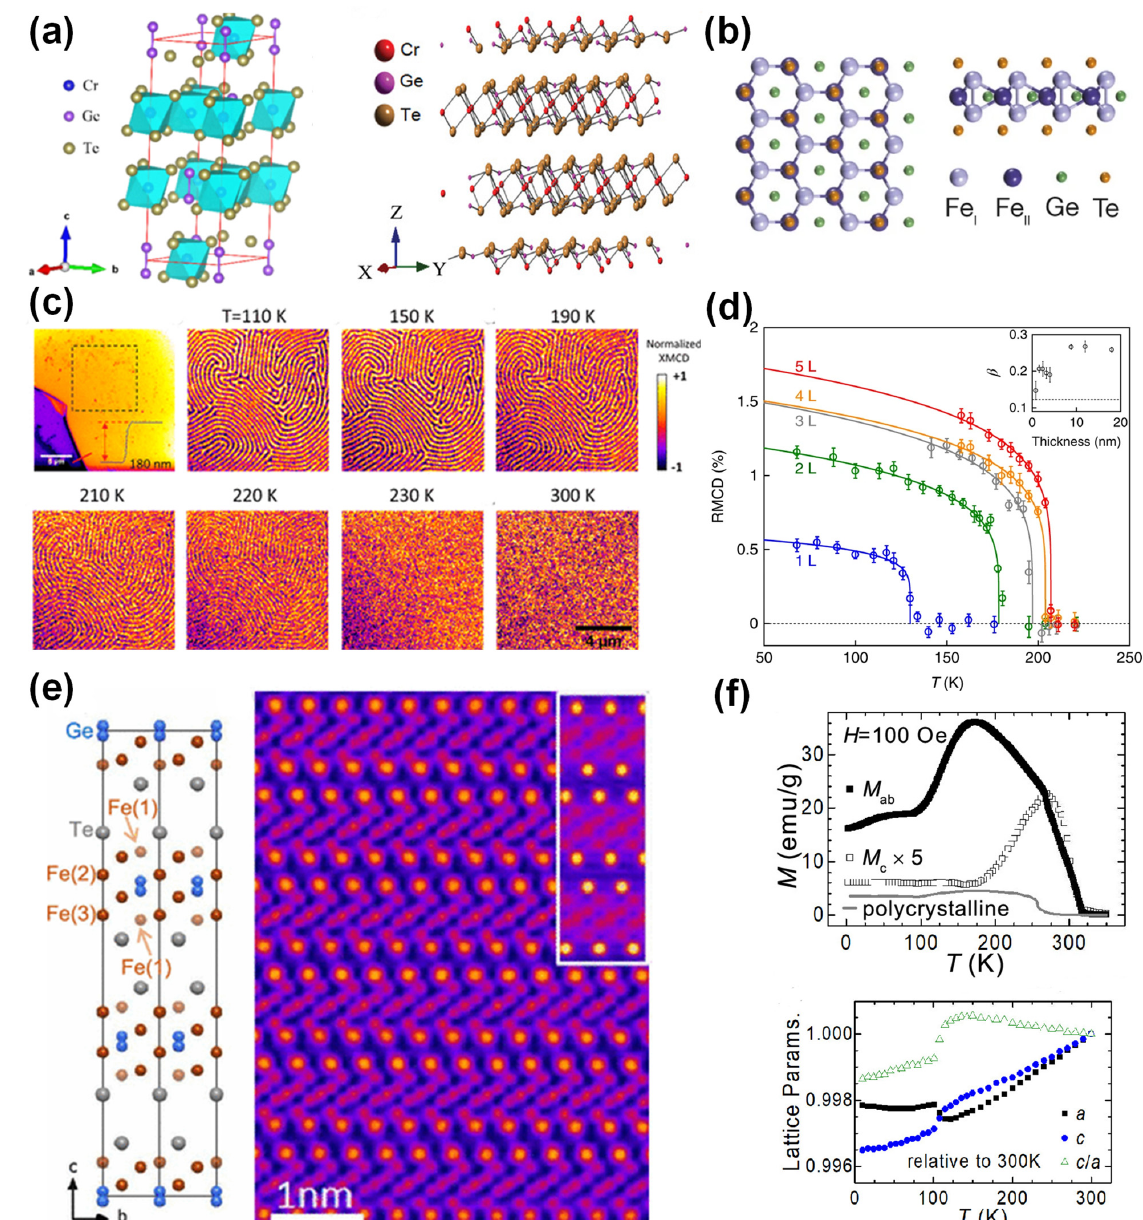
Figure 2. ( a ) Crystal structure of Cr 2 Ge 2 Te 6 . Reused with permission from [53, 54] . ( b ) Structure of monolayer FGT. The left panel shows the view along [001]; the right panel shows the view along [010]. Reused with permission from [65] . ( c ) Temperature-dependent domain imaging of Fe 3 GeTe 2 . Reused with permission from [69] . ( d ) Criticality analysis for FGT flakes of different thicknesses. Reused with permission from [67] . ( e ) Crystal structure and real space STEM image of Fe 5 − x GeTe 2 . The left panel is the average crystal structure obtained from single-crystal X-ray diffraction data where Fe (1) and Ge are split sites; the right panel is a Z-contrast HAADF image with simulation overlaid in the region outlined by a white box. Reused with permission from [70]. ( f ) Magnetic characterization of bulk single crystals and polycrystalline samples. Temperature dependence of the magnetization upon cooling in an applied field H//c (Mc) and H ⊥ c (Mab) for single crystals as well as data for the polycrystalline sample (upper panel). Normalized lattice parameters reveal a strong magnetoelastic coupling near 100 K (lower panel). Reused with permission from